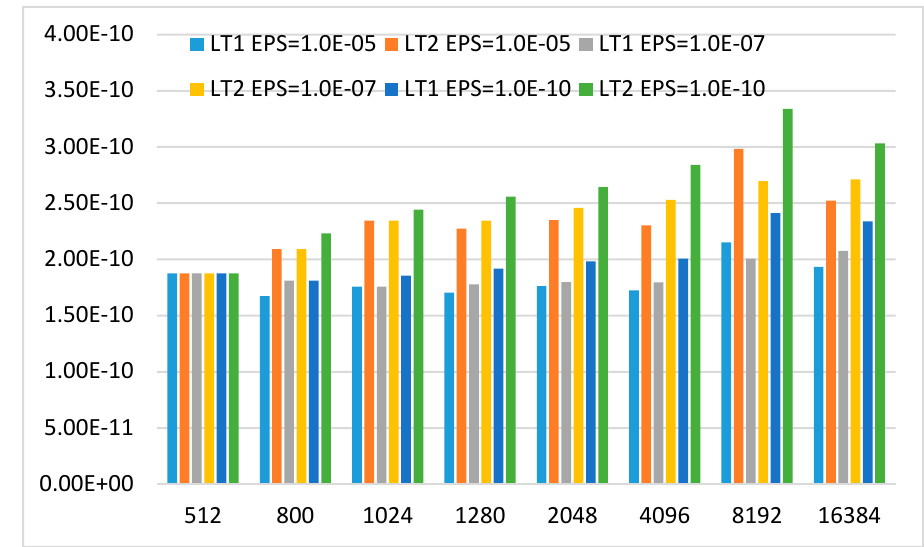
Figure 8. Computational time scaled by Nlog 3 N with CMAX = 64(LT1 is the butterfly algorithm and LT2 is the proposed method. EPS is desired precision in interpolative decomposition, CMAX is the number of columns in each sub-matrix on level 0). Mathematics 2019 , 9 , x FOR PEER REVIEW